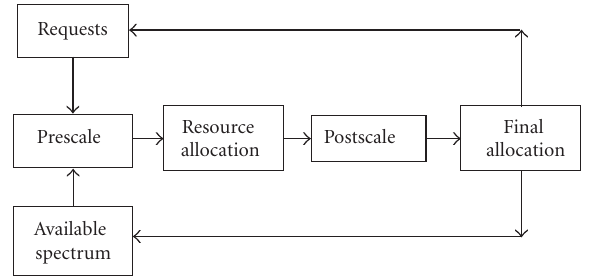
Figure 1: The resource allocation process flow